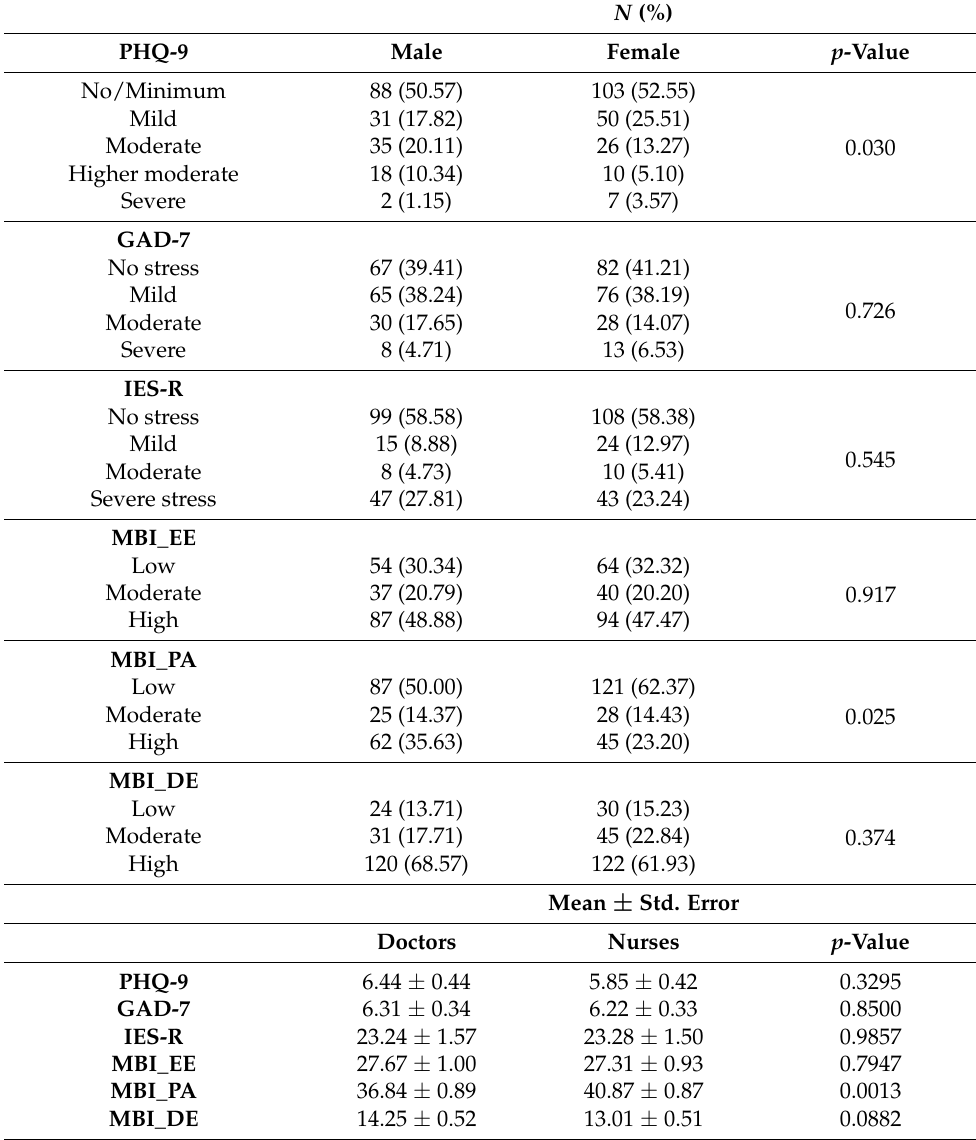
Table 3. Psychometric scale outcomes: means and level of severity for physician and nurses. PHQ-9 = Patient Health Questionnaire-9; GAD-7 = General Anxiety Disorder-7; IES-R = Impact of Event Scale- Revised; MBI_EE = Maslach Burnout Inventory, Emotional Exhaustion; MBI_PA = Maslach Burnout Inventory, Personal Accomplishment; MBI_DE = Maslach Burnout Inventory,